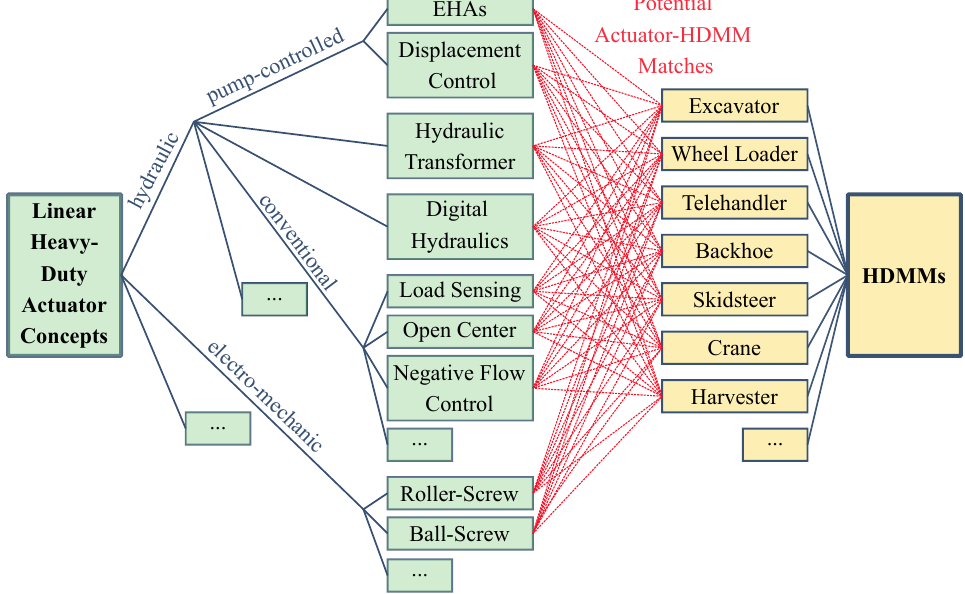
Figure 1. A rough, incomplete classification of linear heavy-duty actuator concepts and of HDMMs as well as the visualization of the resulting potential actuator-HDMM